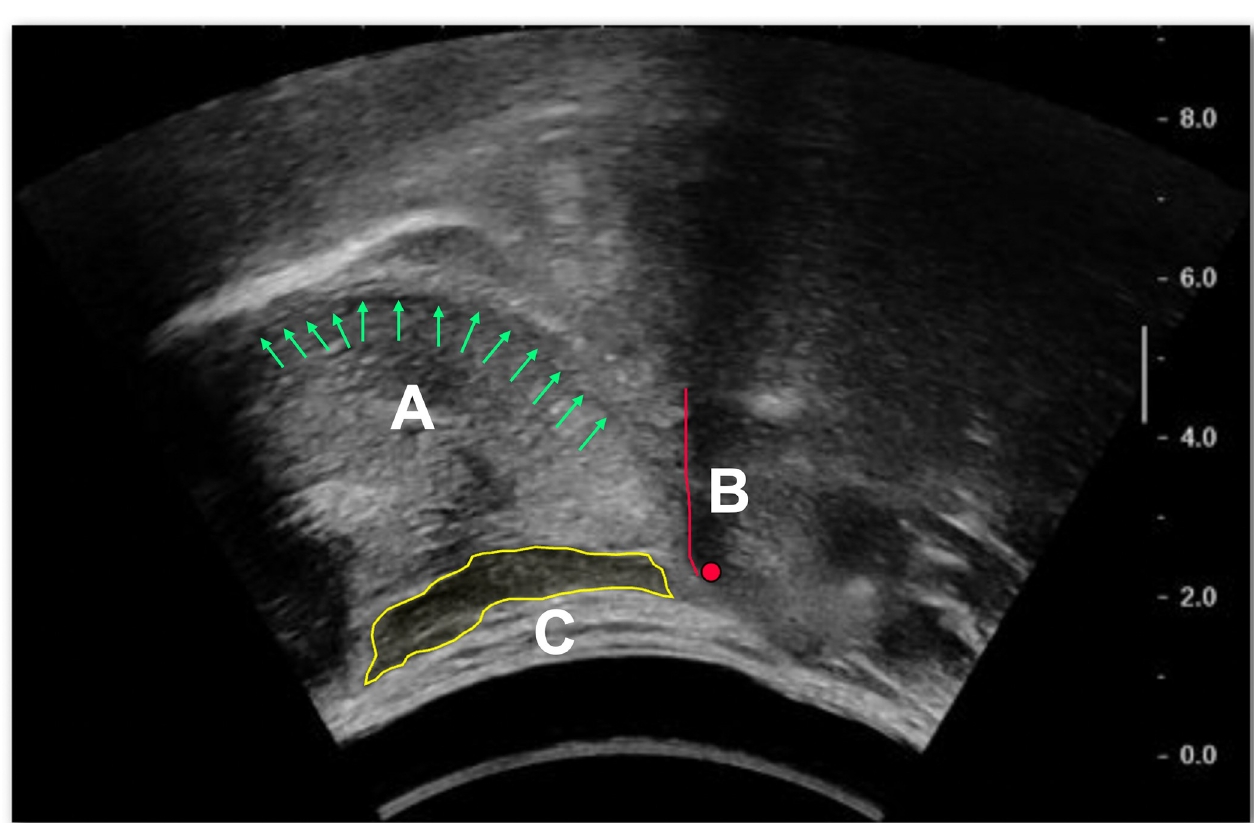
Fig 1. Sample ultrasound image showing the tongue surface and tongue base (A), hyoid bone (B), and geniohyoid muscle (C).